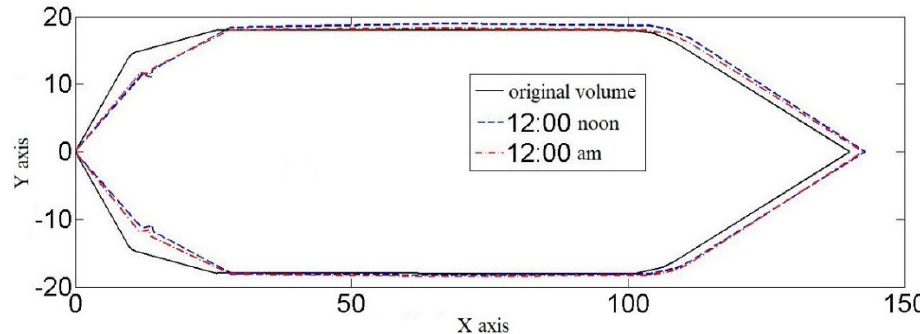
Figure 12. The comparison of airship shapes (X-Y view) (units: m).